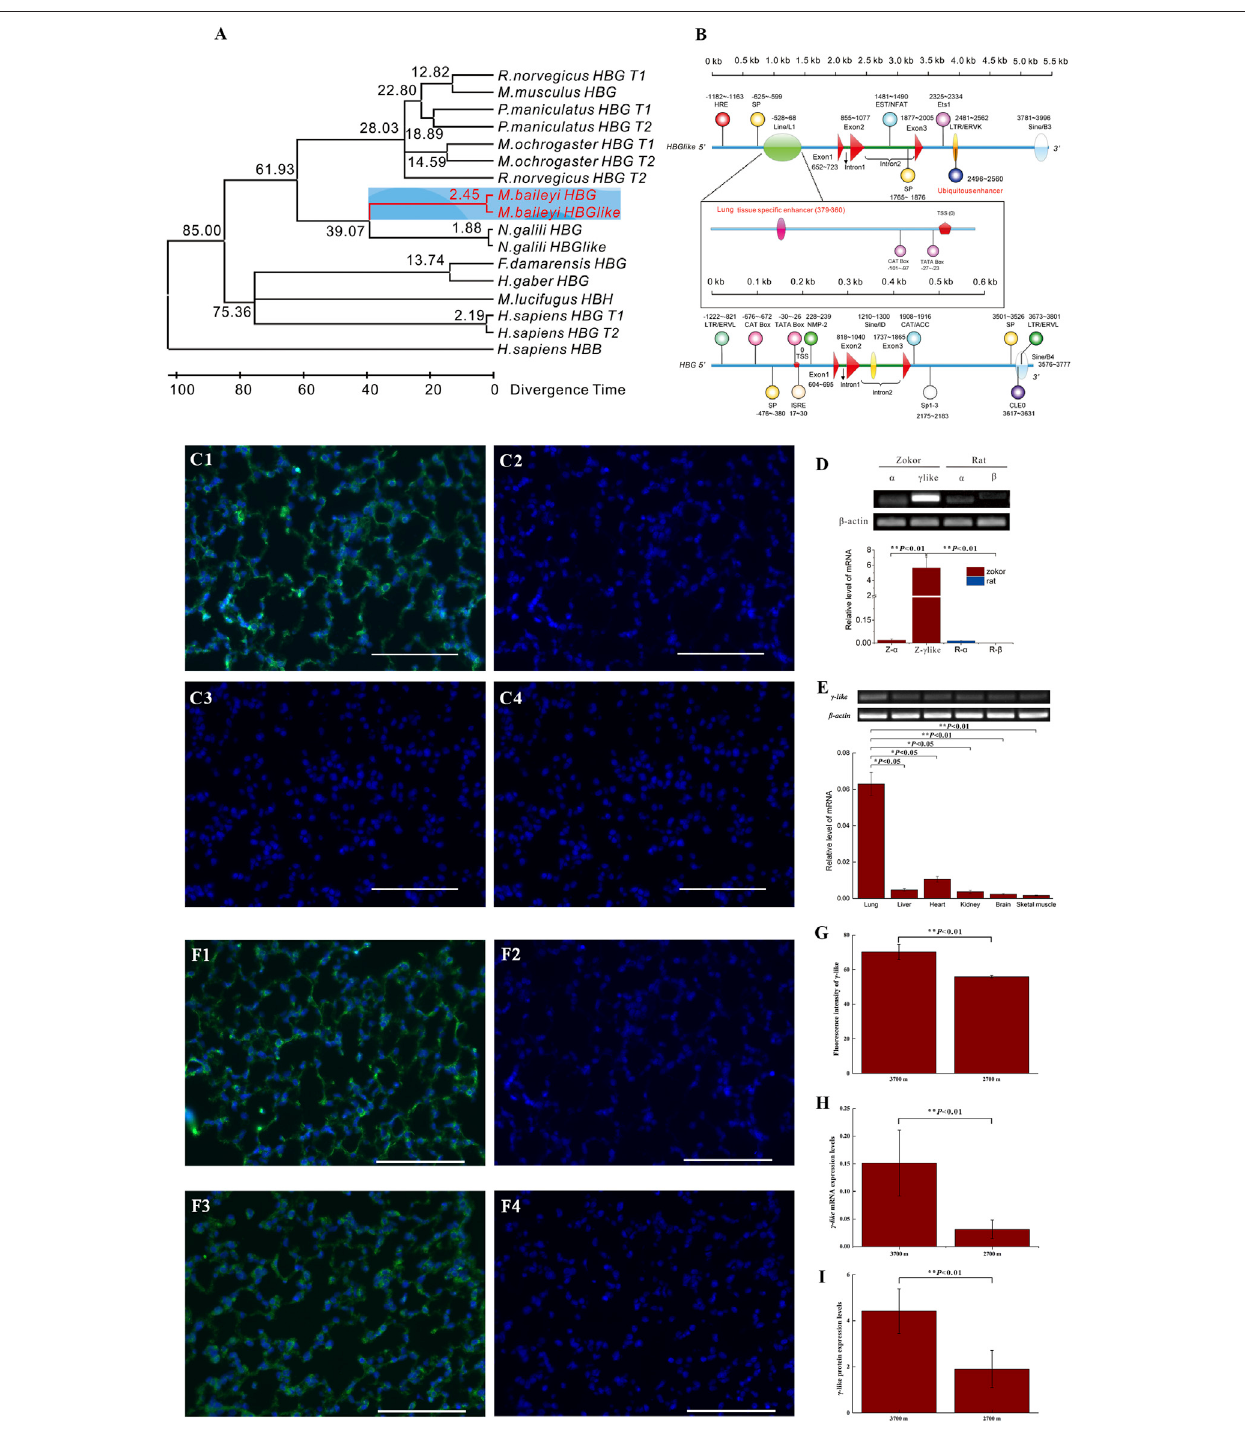
FIGURE 3 | The structure, tissue-speci fi c expression, and response to hypoxia of γ -like . (A) Maximum-likelihood tree of the γ -like and γ coding sequences of eight studied species. The divergence time was predicted by MEGA7.0 program and is shown on each node. The range of Euarchontoglires-Laurasiatheria divergence times spanning about 85 Mya was used as a calibration point. (B) The structures of γ -like and γ of plateau zokor. The whole structures contain 2 kb of 5 ′ fl anking sequence, three exons, two introns, and 2 kb of 3 ′ fl anking sequence. The promoters, repeats, transposons, and transcription regulatory elements were indicated. (C1 – C4) Immuno fl uorescence staining for γ -like subunit in lung tissues of plateau zokor and Sprague-Dawley rat (C1, C2 - plateau zokor, C3, C4 - Sprague-Dawley rat). (C2,C4) Negativecontrols.Objectivemagni fi cation:×40,scalebar=100 μ m.TheDAPIlabeledthenucleusblue,the γ -likesubunitwaslabeledgreen. (D) ThemRNAexpression